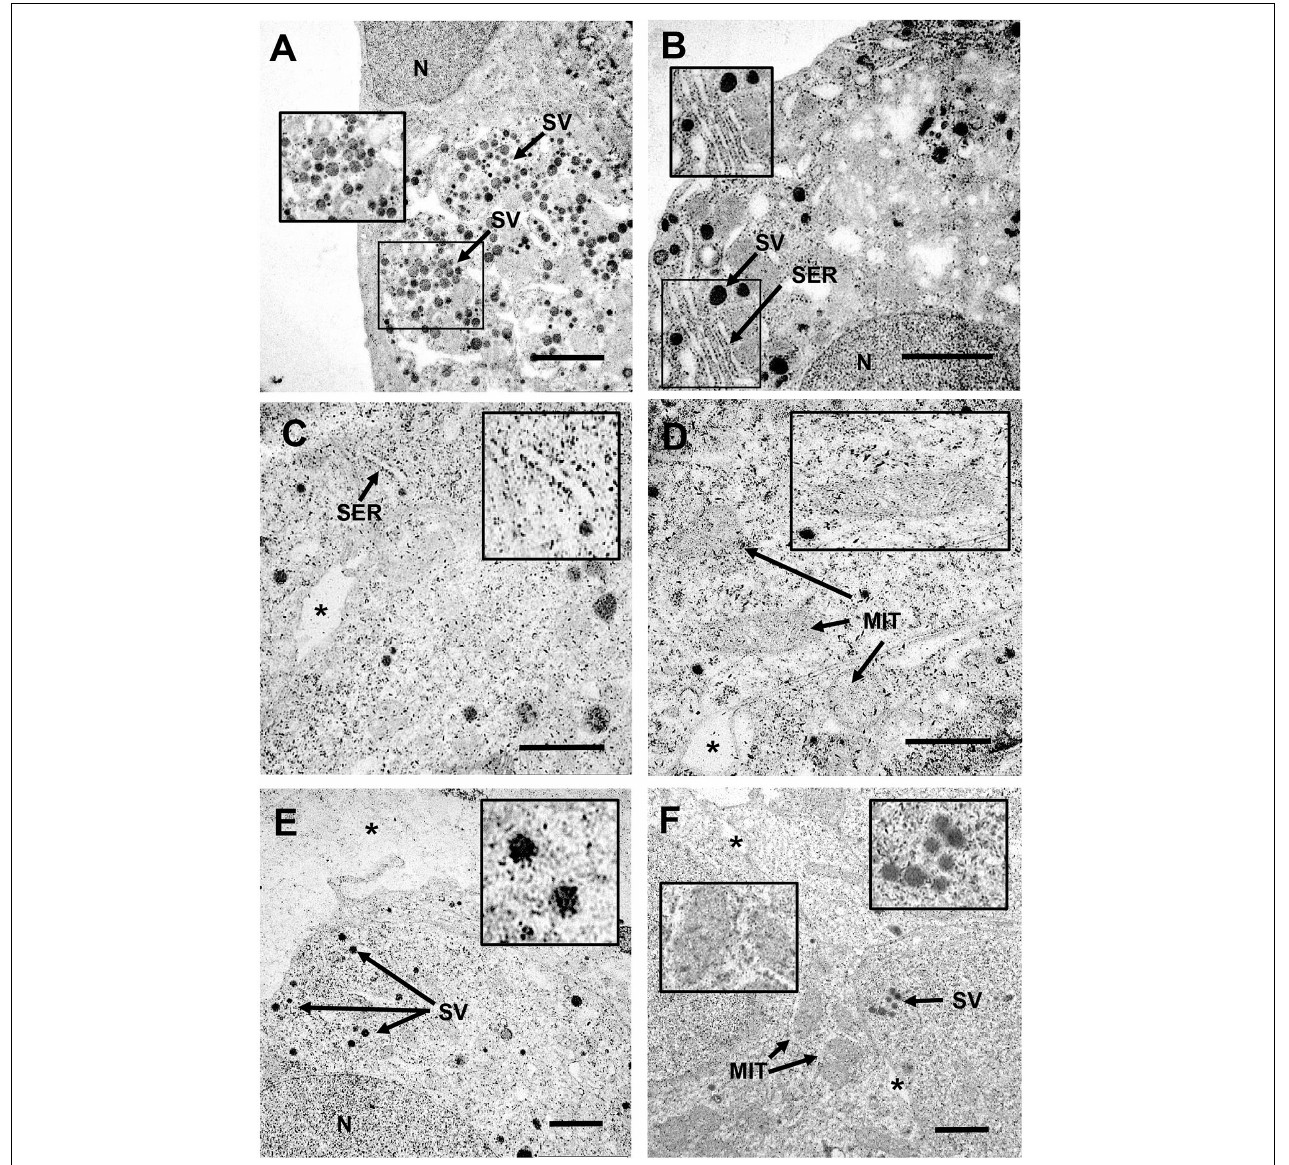
FIGURE 4 | Transmission electron microscopy study of uptake and intracellular localization of CB NPs in primary cultures of anterior pituitary cells and in L β T2 cells. Primary cultures of rat anterior pituitary cells were treated for 24 h with CB NPs at a concentration of 50 µ g/mL (A,B) . L β T2 gonadotrope cells were incubated for 24 h with (C–E) or without (F) CB NPs at a concentration of 25 µ g/mL. Cells were then extensively washed and processed for transmission electron microscopy as described in Materials and Methods. In CB NP-treated cells (A–E) , aggregates/agglomerates of CB NPs were freely dispersed within the cytoplasm or associated with different subcellular compartments and organelles in primary pituitary cells (A,B) and in L β T2 cells (C–E) . Arrows indicate mitochondria (MIT), secretory vesicles (SV) and smooth endoplasmic reticulum (SER). Magnifications illustrate the close association of CB NPs with smooth endoplasmic reticulum (B,C) , mitochondria (D) or secretory vesicles (A,E) . In contrast, no CB NPs could be detected in control untreated primary cultures (data not shown) and L β T2 cells (F) . Note that almost no CB NPs aggregates/agglomerates could be detected in the bottom of the culture dish or in intercellular spaces as compared to intracellular compartment (*). N , nucleus. Scale bar: 2 µ